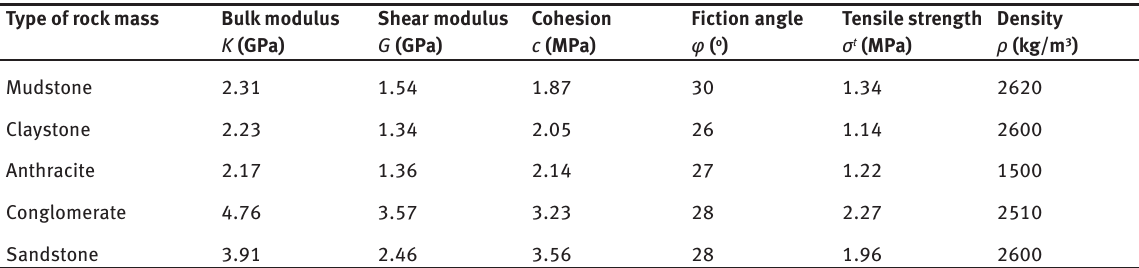
Table 1: Mechanical properties of rock mass in the studied region